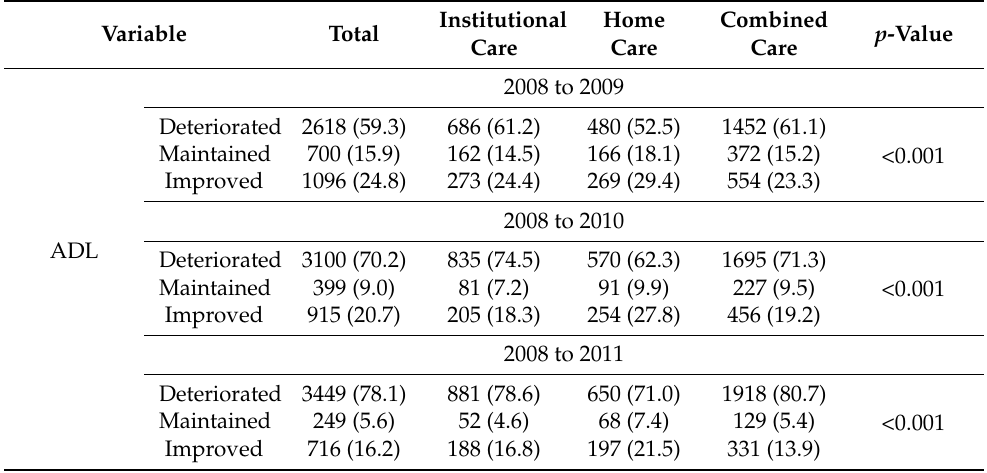
Table 2. Deterioration, maintenance, and improvement of ADL and cognitive function over time according to service type ( n